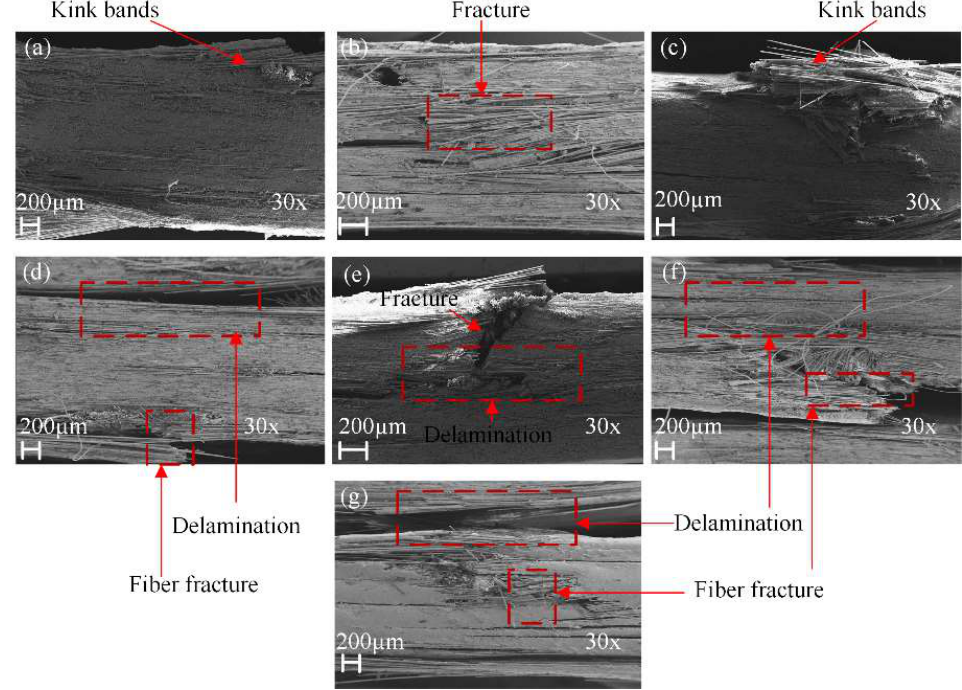
Figure 18. SEM images of dry flexural specimens ( a ) GF ( b ) BF ( c ) GB1 ( d ) GB2 ( e ) GB3 ( f ) GB4 ( g ) GB5.